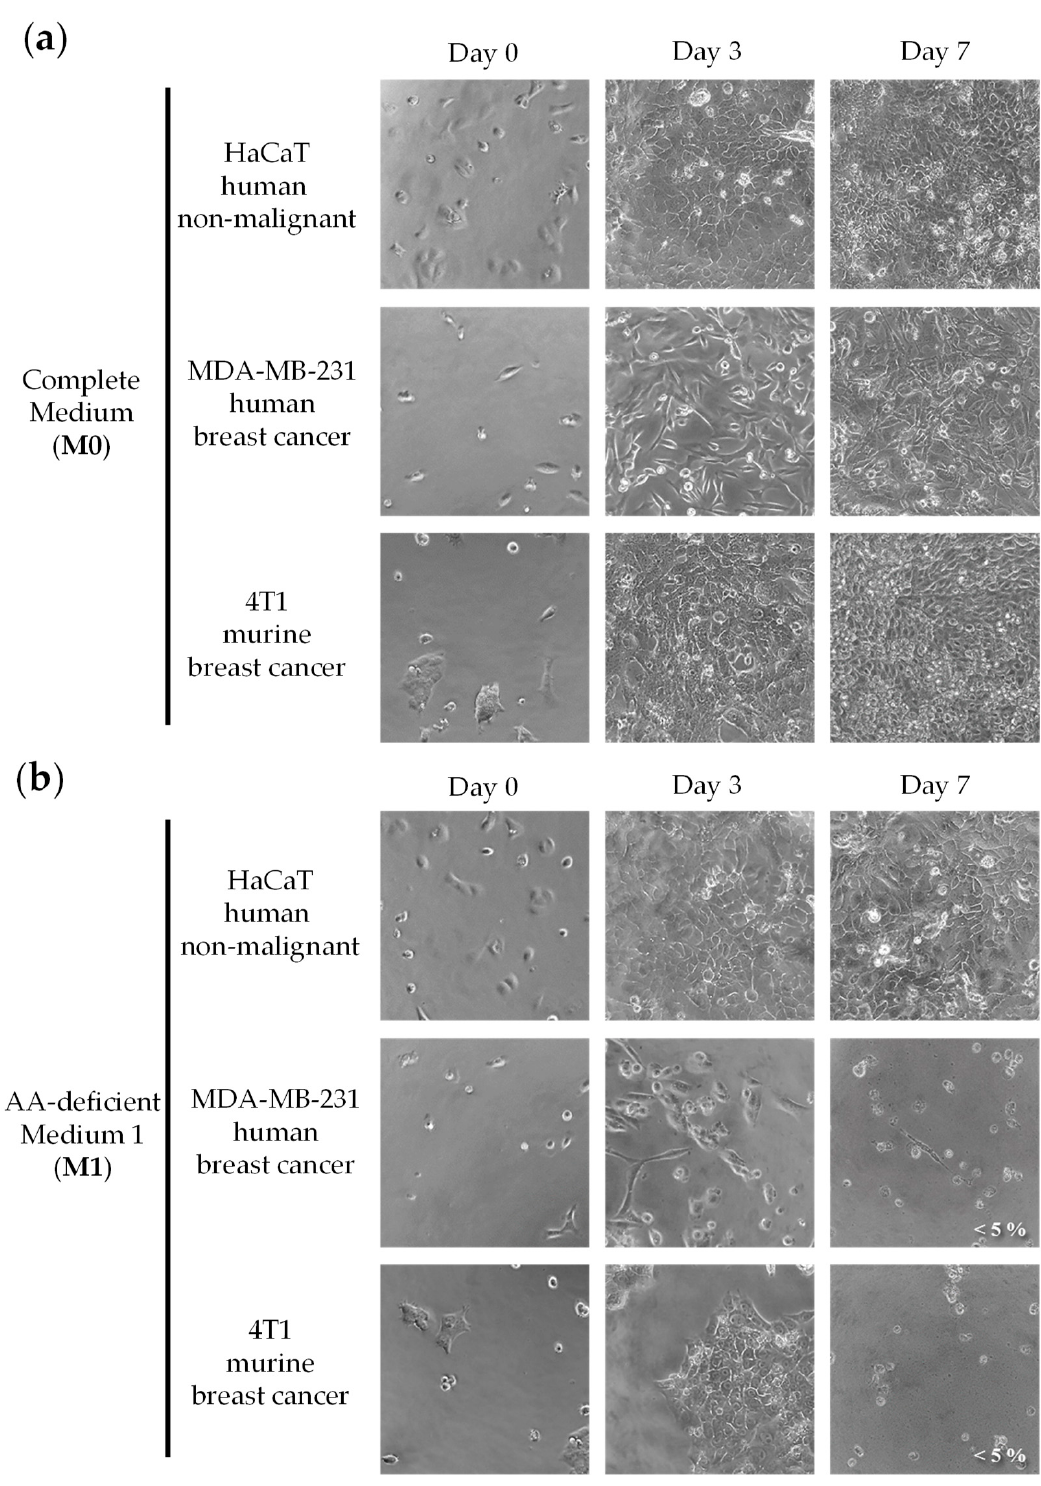
Figure 1. An artificial medium lacking 10 NEAAs induces selective cytotoxic activity in triple-negative breast cancer cells. Cells were grown in a complete medium (M0) or in a medium lacking 10 AAs (M1) for seven days. Cells were monitored by microscopic visualization and photographed on days 3 and 7. Representative photographs at 20× magnification are shown. Cell viability was estimated with the MTT assay and is shown at the bottom right of the photographs when it was less than 10%. The detailed compositions of M0 ( a ) and M1 ( b ) are shown in Table 1.